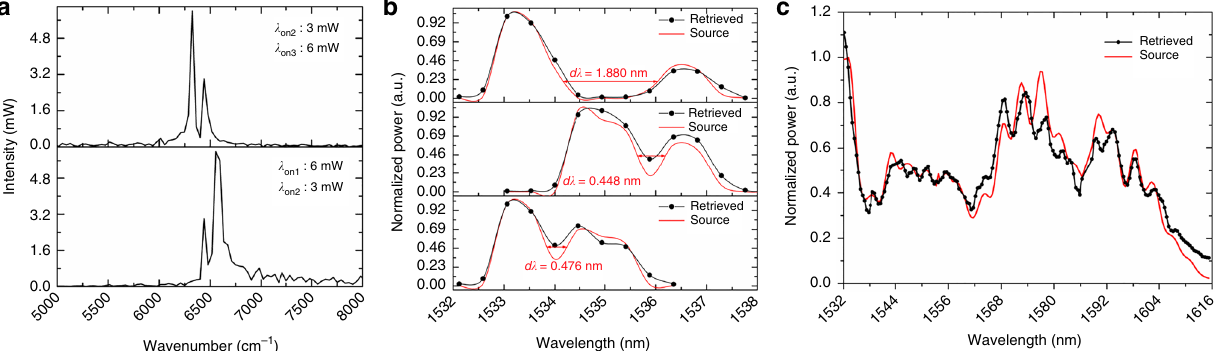
Fig. 6 Double wavelengths and broadband spectrum characterization. a Retrieved spectra with TLS-1 and TLS-2 (set at adjacent on-resonance wavelengths of MRR, respectively) input simultaneously when Δ λ = 0. b Normalized retrieved spectra (black) using the spectra with two broad spectral peaks input (red). c Normalized retrieved spectrum (black) with a broadband source (red) input. The source spectrum is generated from an optical fi ber